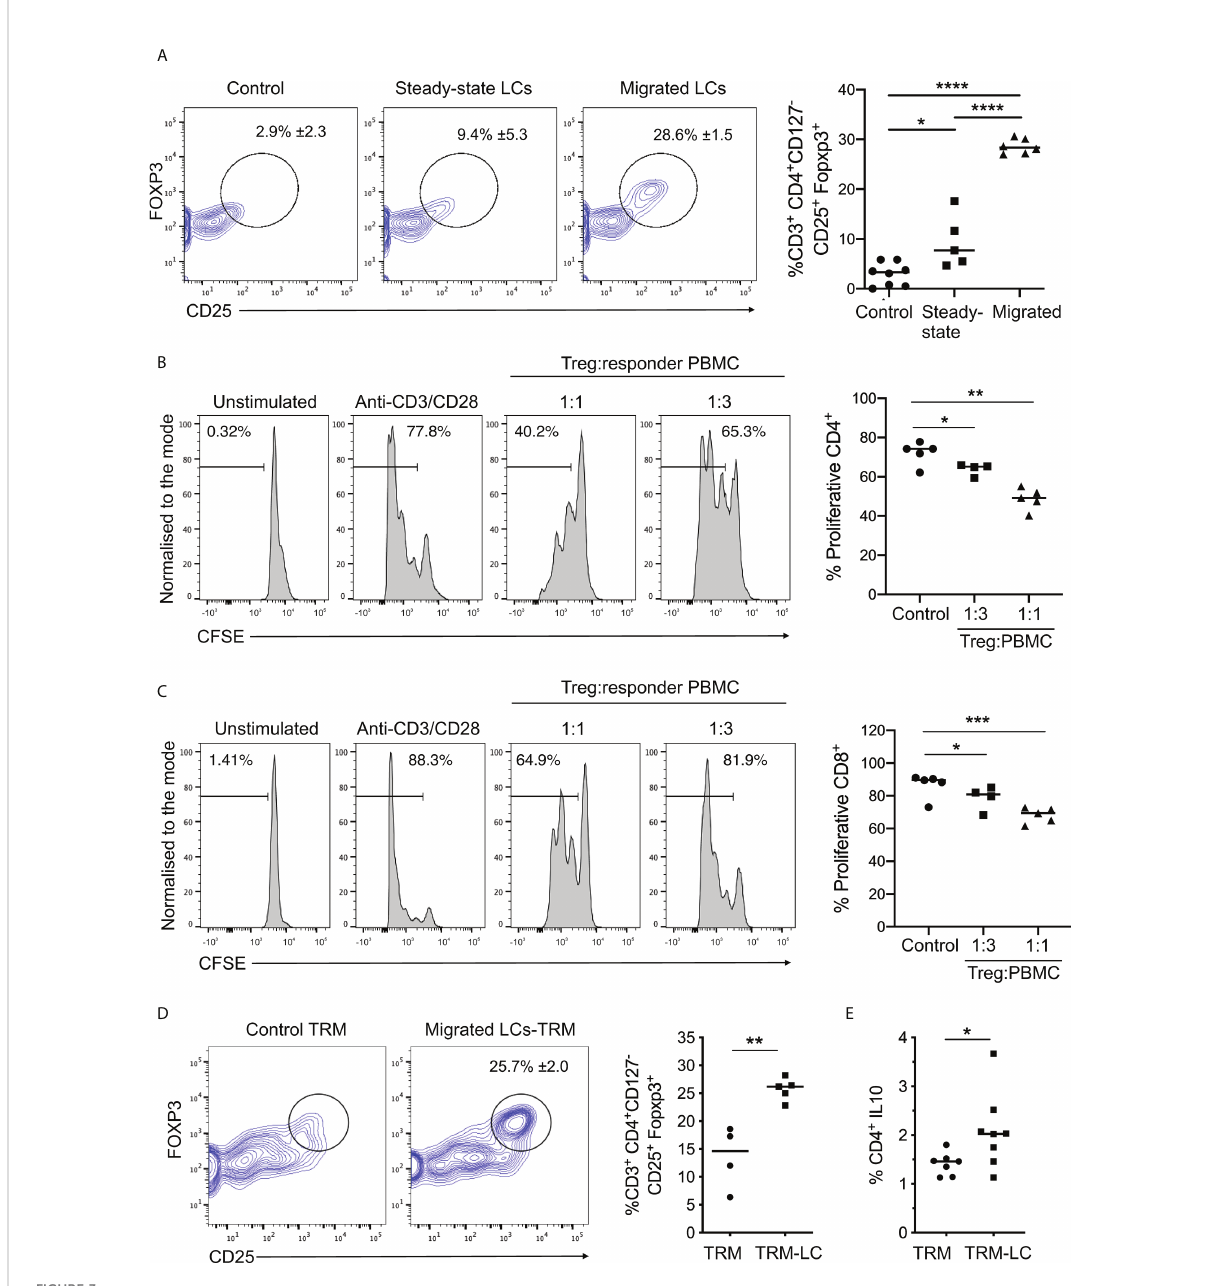
FIGURE 3 Migrated LCs more ef fi ciently prime functional Treg responses. (A) Flow cytometry analysis of Tregs induced after co-culture of steady-state and migrated LC with CD4+ naive T cells as in Fig. 2C . n=8 control, n=5 steady-state LCs and n=6 migrated LCs from independent donors. *p<0.05, **p<0.01, ***p<0.001. (B) Proliferation analysis of CD4+ T cells using CFSE labelled PBMCs after 3-day co-culture with autologous puri fi ed CD3+CD4+CD127-CD25+ Tregs. The percentages of proliferating CD4+ cells stimulated with plate bound anti-CD3 and soluble anti- CD28 are displayed at ratios of 1:1 and 1:3 Treg : PBMC (n=5 from 3 independent LC donors). *p<0.05, **p<0.01. (C) Proliferation analysis of CD8+ T cells using CFSE labelled PBMCs after 3-day co-culture with autologous puri fi ed CD3+CD4+CD127-CD25+ Tregs. The percentages of of proliferating CD8+ cells stimulated with plate bound anti-CD3 and soluble anti-CD28 are displayed at ratios of 1:1 and 1:3 Treg : PBMC (n=5 from 3 independent LC donors). *p<0.05, ***p<0.001. (D) Flow cytometry assessment of the percentage of Tregs induced after 5-day co- culture of migrated LC with autologous TRMs extracted from human epidermis. 5-day cultures of TRMs alone were used as control. Tregs were identi fi ed as CD3+CD4+CD127-CD25+FOXP3+ cells. n=5 independent LC donors. **p<0.01. (E) Percentage of IL-10 producing CD4+ cells after co-culture of TRMs in the presence or absence of migrated LC. n=8. *p<0.05,